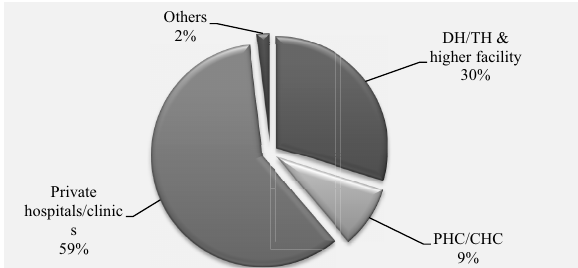
Figure 5. Types of health